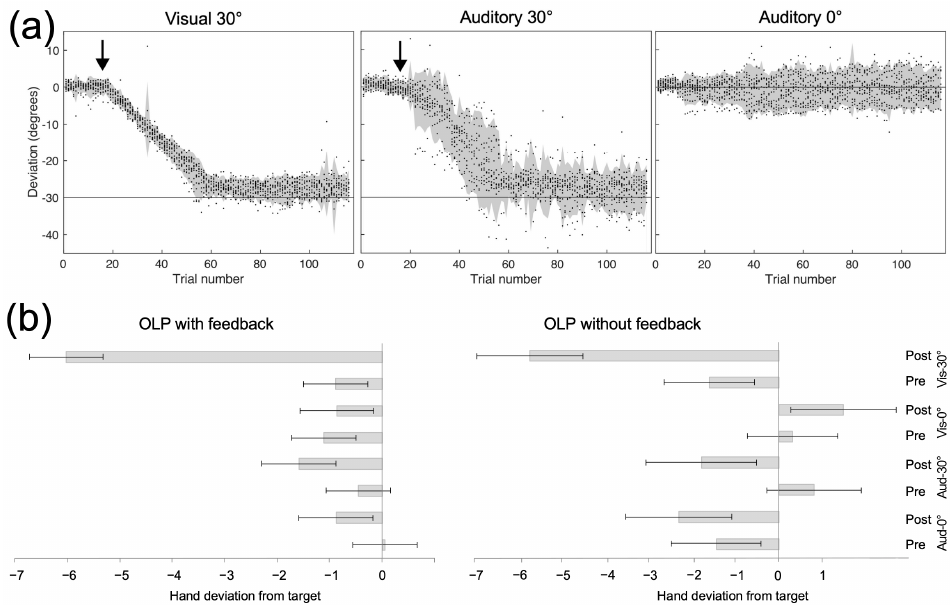
Figure 3. ( a ) Adaptation effects with visual and auditory feedback. The vertical arrow indicates the time-point when a mismatch was gradually induced. Dots indicate pointing performance of individual participants at each trial [adapted from [81]]. ( b ) Results of open-loop pointing (OLP) with ( left ) or without ( right ) vision of the target revealed only significant adaptation effects after visual adaptation with a shift of 30 degrees.